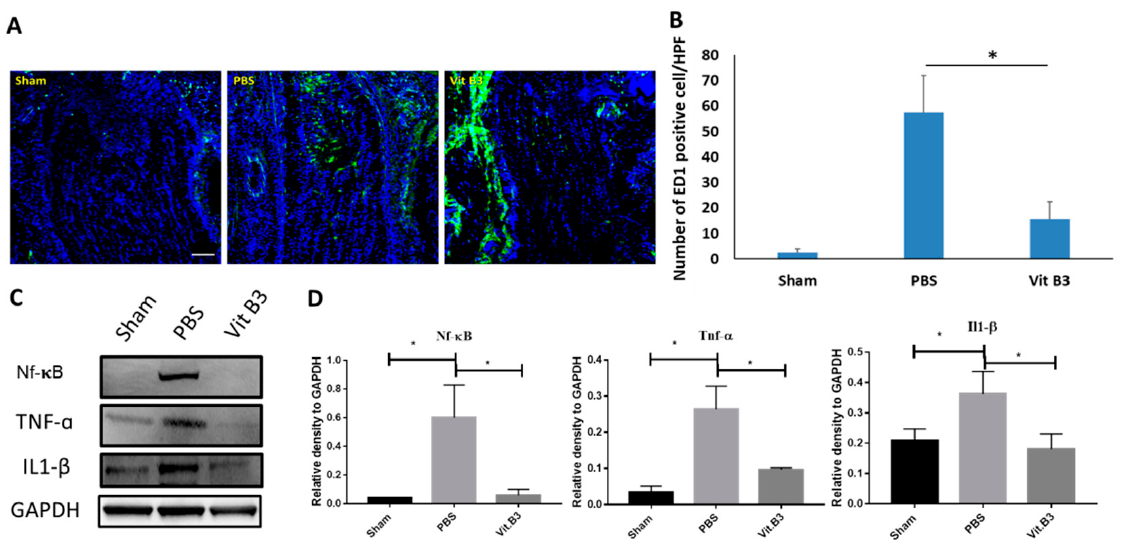
Figure 4. On macrophage infiltration in the ON and inflammation in the retina, vitamin B3 has an anti-inflammatory impact. ( A ) Pictures of the ONs in longitudinal sections showing ED1 staining. Green markers identified the ED1-positive cells. Blue labels identified the cell nuclei. ( B ) Counting the number of ED1-positive cells in each HPF. In comparison to the PBS-treated group, the vitamin B3-treated group had a considerably lower number of ED1-positive cells (* p < 0.05; n = 6 per group; scale bar: 100 µ m). ( C ) Typical image of the day 2 following rAION induction Western blotting examination of the retinal material. ( D ) Measurement of the NF-B, IL-1, and TNF protein bands. Using the iBright imaging program, each value was calculated and normalized to glyceraldehyde-3-phosphate dehydrogenase (GAPDH). NF-B, IL-1, and TNF- expression were all significantly higher in the PBS-treated group than in the sham group, while they were all significantly lower in the vitamin B3-treated group than in the PBS group (* p < 0.05; n = 6 per group). Data were presented as mean ± SD.